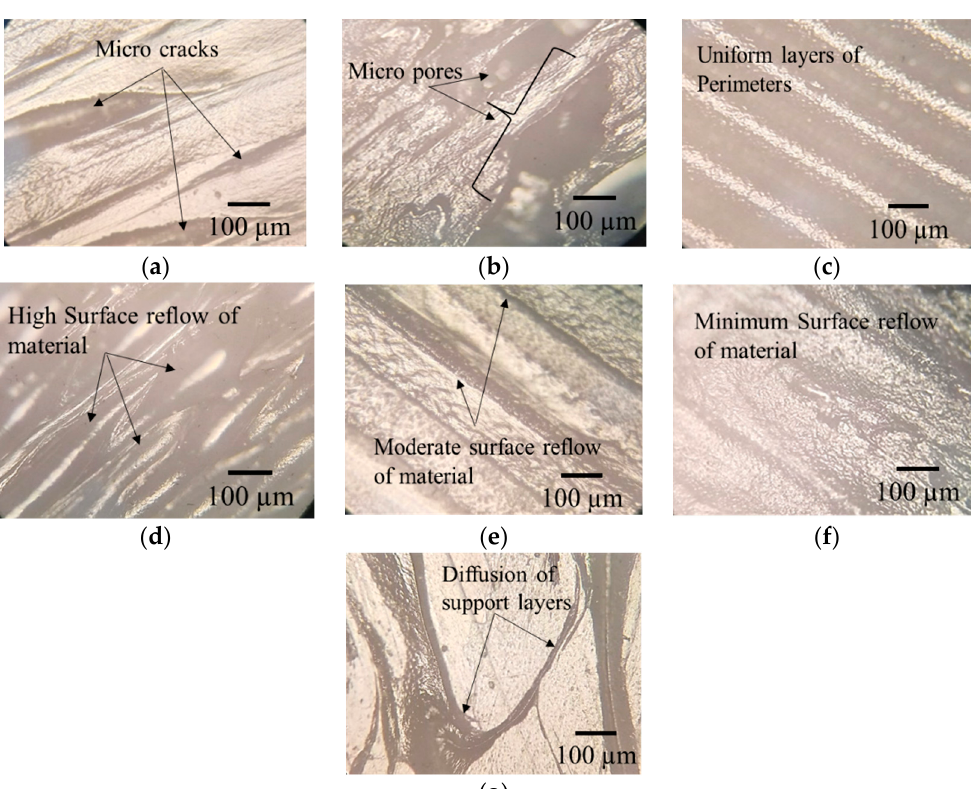
Figure 7. Optical images ( a ) formation of microcracks at 0.3 mm layer height, ( b ) formation of micropores at 0.3 mm layer height, ( c ) uniform layers of perimeters, ( d ) high surface reflow of material at 90 °C bed temperature, ( e ) moderate surface reflow of material at 80 °C bed temperature, ( f ) minimum surface reflow of material at 70 °C bed temperature, ( g ) diffusion of support layers at 45° build orientation.